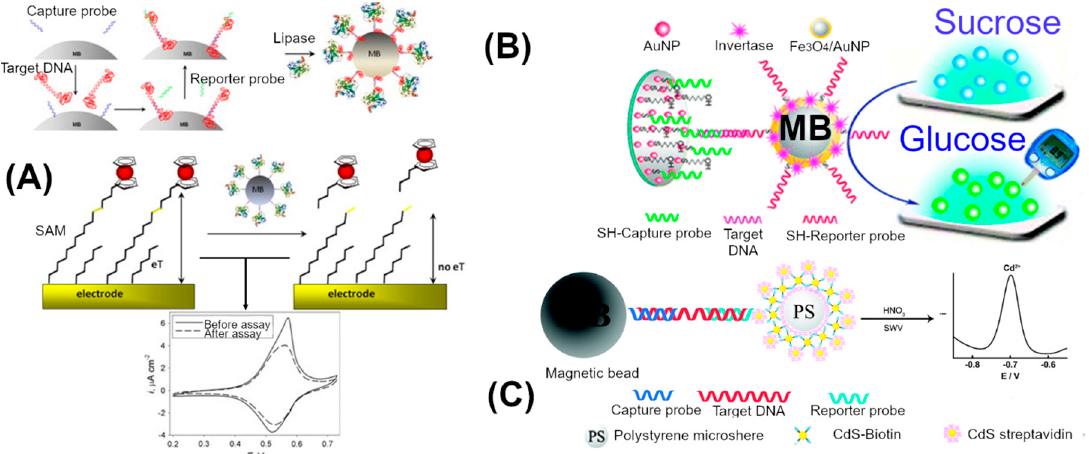
Figure 3. Schematic presentation of an electrochemical signal amplification for DNA detection. ( A ) DNA sandwich with a lipase labeled reporter probe for detection of Lactobacillus brevis DNA. Lipase was designed to bind with capture and target molecular recognition elements. During electrochemical analysis, lipase cleaves off the ferrocene from 9-mercaptononyl, 4-ferrocene aminobutanoate monolayer over the electrode surface. This results in the reduction of the observed current using